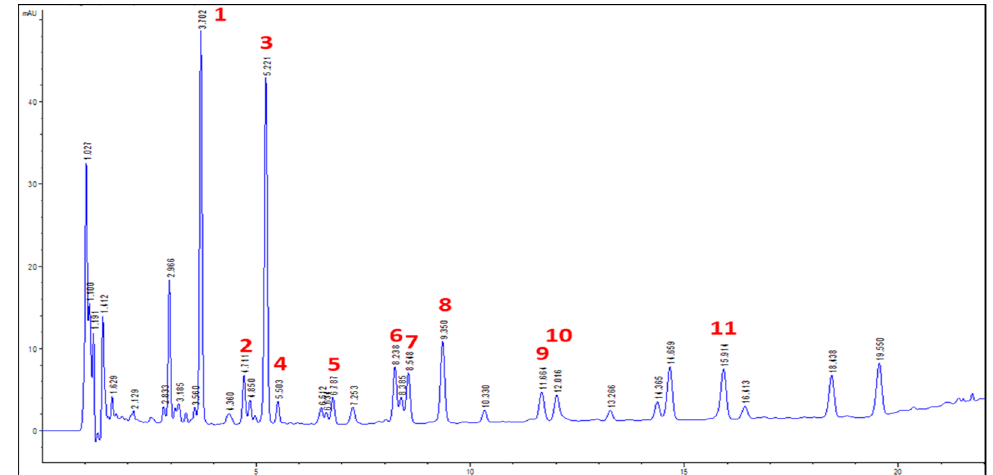
Figure 3. The UPLC profile of Astragali Complanati Semen (254 nm).